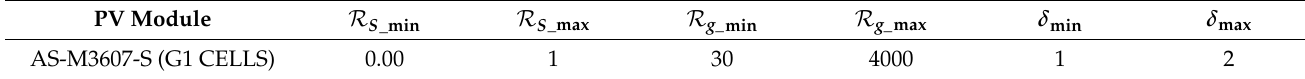
Table 7. Lower and upper bounds of the parameters.